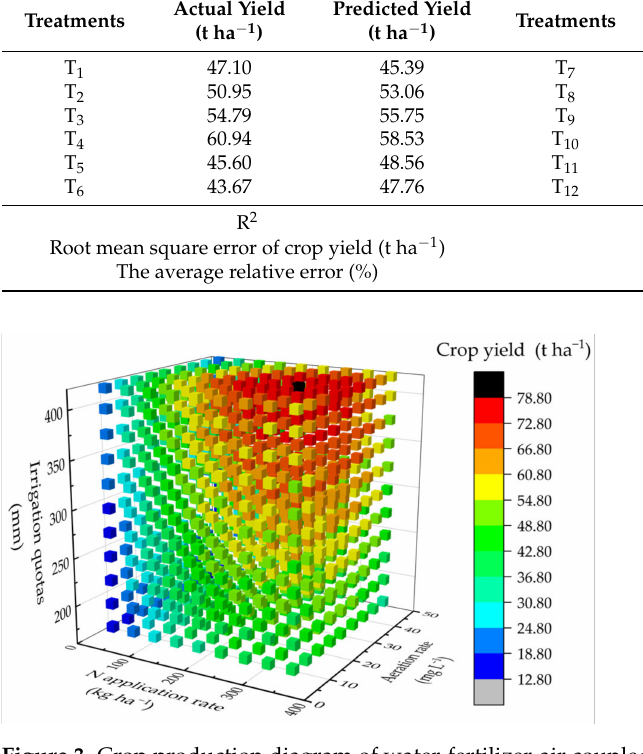
Figure 3. Crop production diagram of water-fertilizer-air coupled